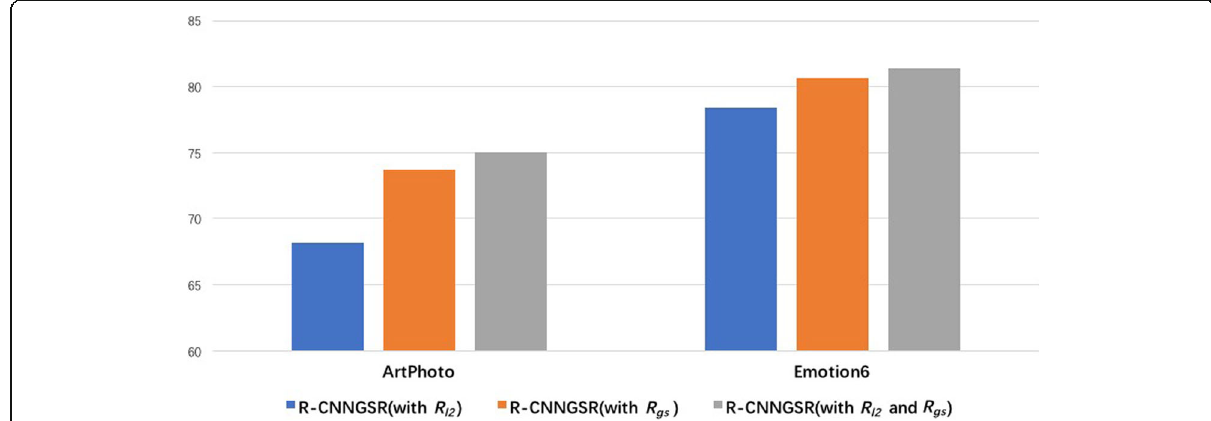
Fig. 5 Effect of different regularizations for R-CNNGSR on ArtPhoto and Emotion6